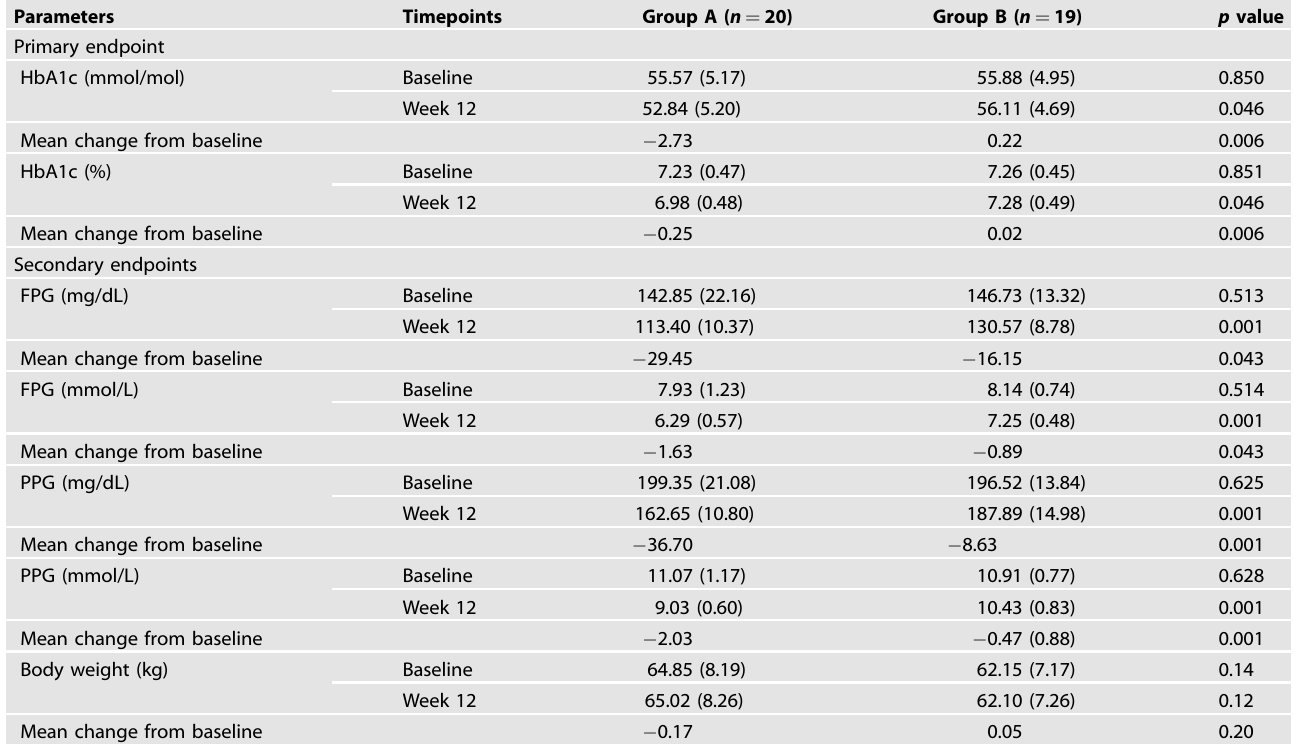
Table 2. Change from baseline to week 12 visit in the levels of HbA1c, FPG, PPG, and body weight.